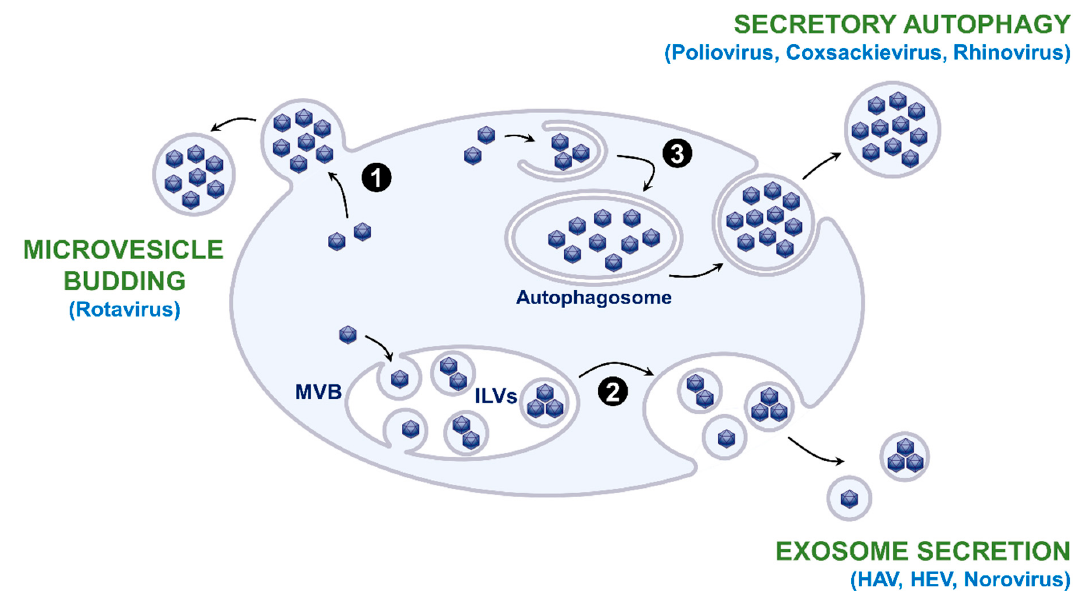
Figure 1. Origin of extracellular vesicles (EVs) and EV hijacking by naked viruses. EVs can directly bud at the plasma membrane as microvesicles ( 1 ). They can also bud into multivesicular bodies (MVBs) and form intraluminal vesicles (ILVs) that are released as exosomes as a result of the fusion of MVBs with the plasma membrane ( 2 ). EVs can also be released after the fusion of double-membraned autophagosomes with the plasma membrane, a mechanism termed secretory autophagy ( 3 ). Apoptosis can also generate EVs called apoptotic bodies, but this mechanism is not shown in the figure. Examples of naked viruses that exploit these different EV production pathways are mentioned in light blue.